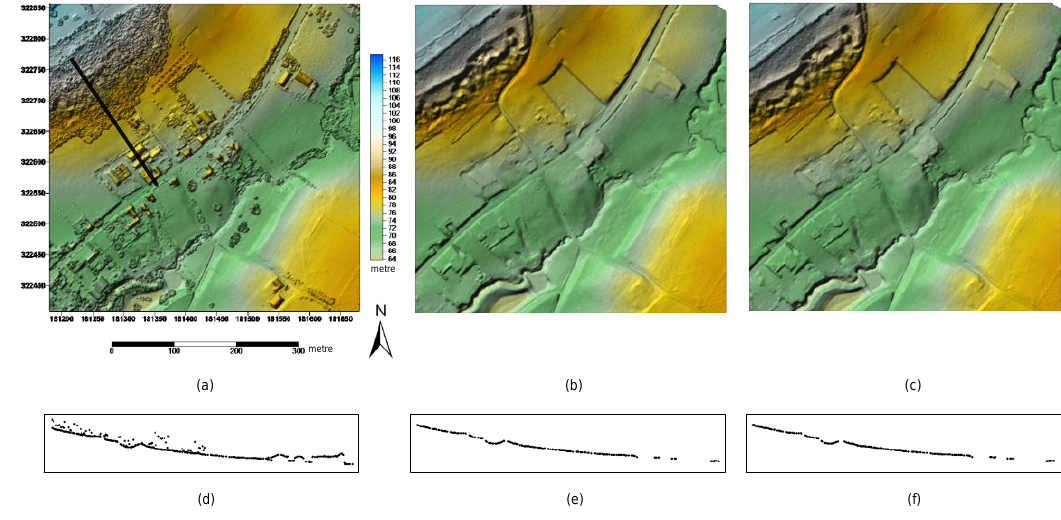
Figure 14. Results of the proposed method filtering the Actueel Hoogtebestand Nederland (AHN) Test Site 1: ( a ) digital surface model (DSM) generated from raw point clouds (the dark line denotes profile position); ( b ) digital elevation model (DEM) generated from true ground points; ( c ) DEM generated from ground points derived by the proposed filter; ( d ) LiDAR points along the profile in ( a ); ( e ) LiDAR points along the profile in ( b ); and ( f ) LiDAR points along the profile in ( c ).